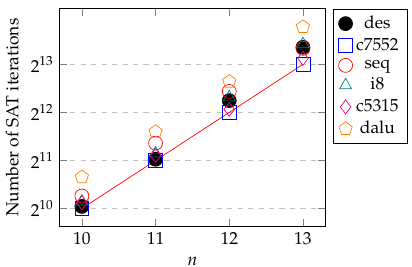
Figure 11. Evaluation of SAT resilience vs. key size.